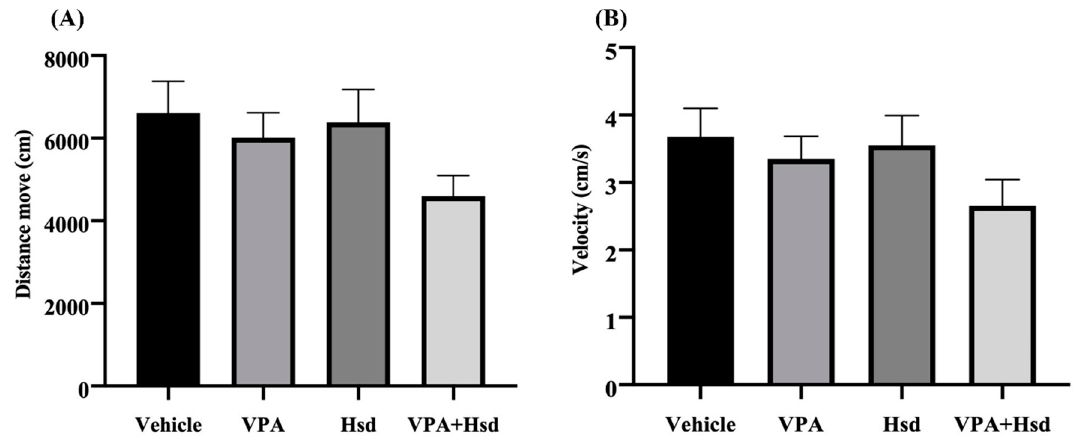
Figure 3. Locomotor activity in the novel object recognition (NOR) test defined by the distance moved ( A ) and velocity ( B ) was significantly similar among all four groups ( p > 0.05).